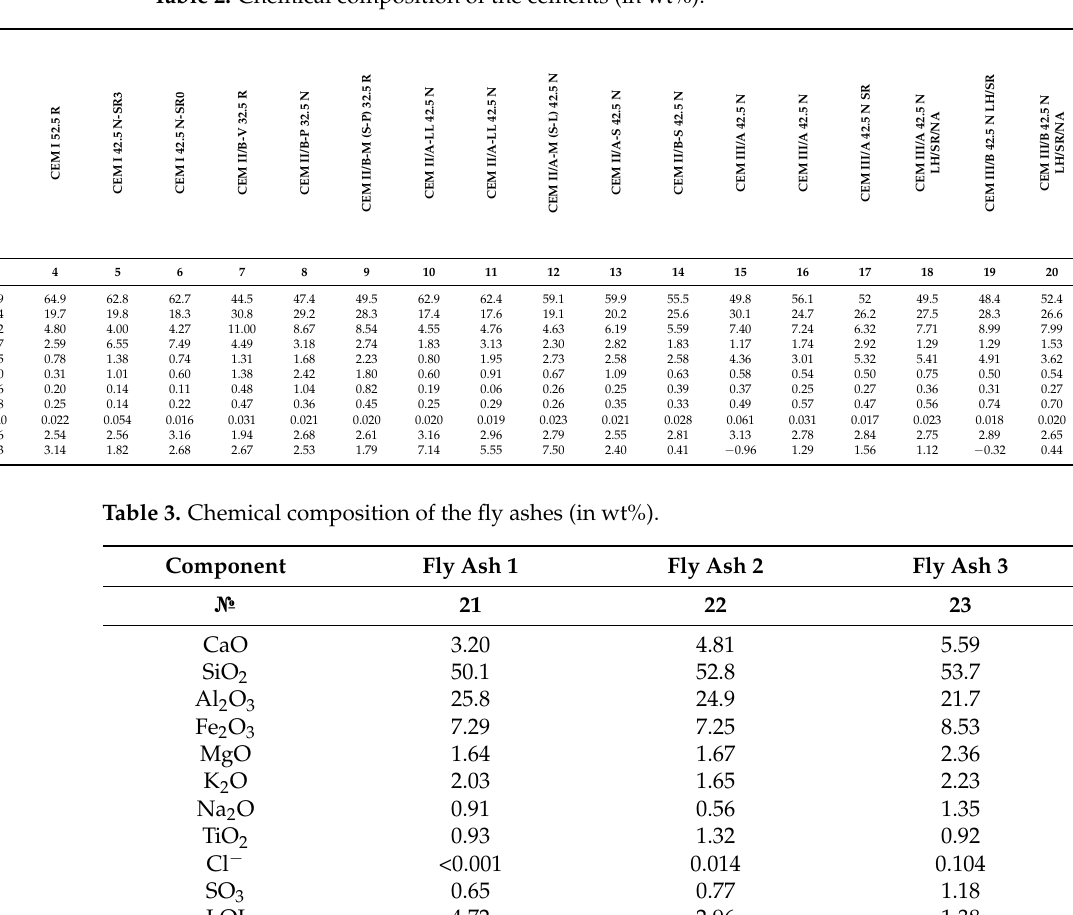
Table 2. Chemical composition of the cements (in wt%).